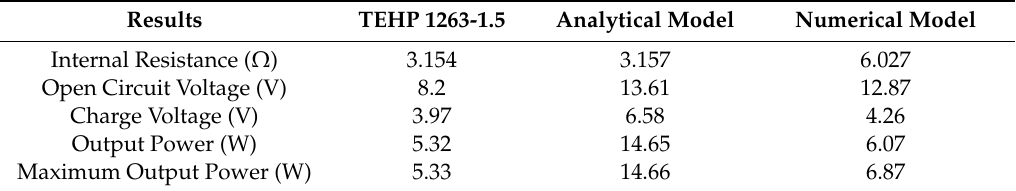
Table 2. Results of the analytical and numerical models and real values, considering a load resistance of 2.96 Ω , T c = 30 °C, T h = 300 °C and 126 thermoelectric pairs of the module TEHP 1263-1.5.